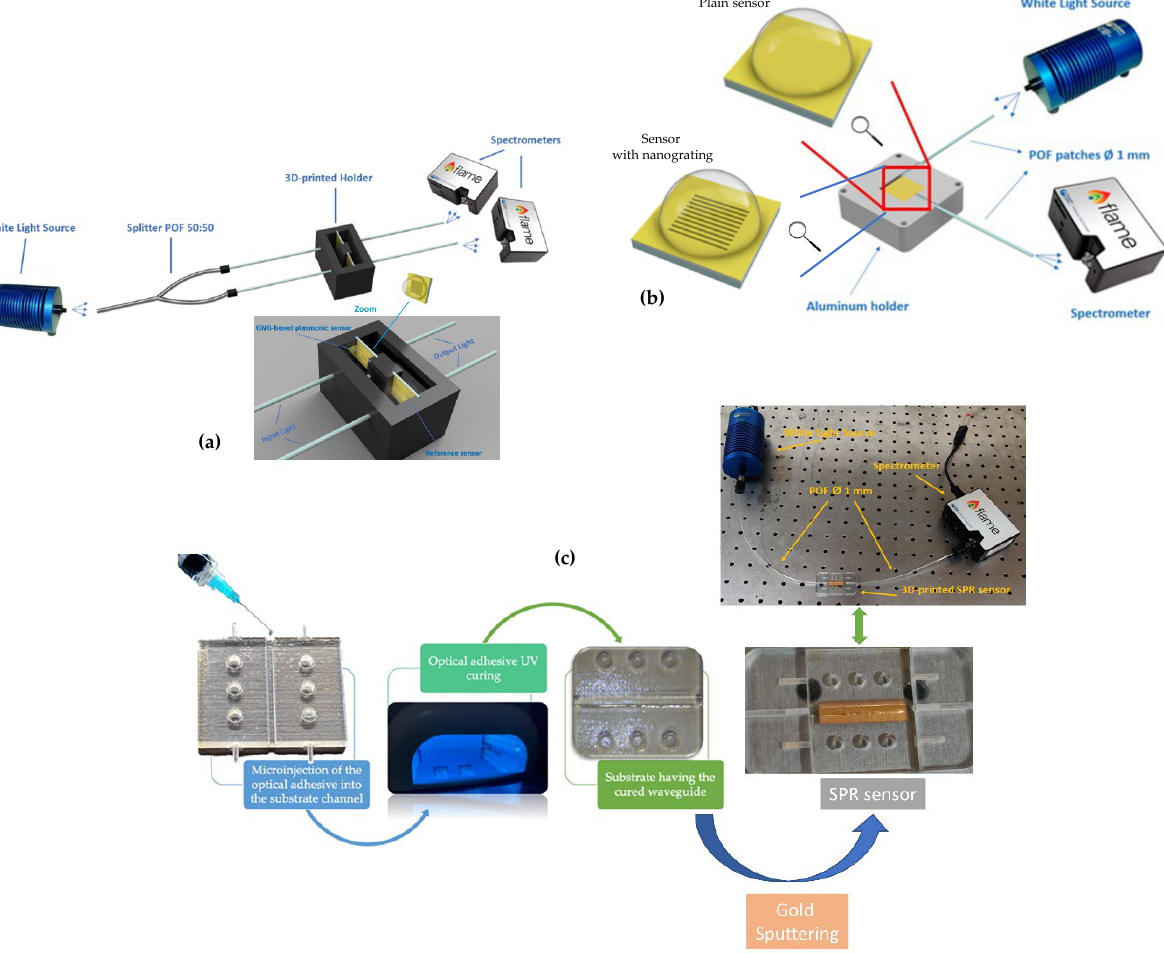
Figure 8. Plasmonic sensor configurations based on extrinsic POF sensors: ( a ) PMMA-based nanoplasmonic sensor chip monitored by exploiting the transparency of the substrate (image adapted from [63]); ( b ) PMMA-based plasmonic chips monitored by a custom setup produced to excite the plasmonic phenomena via the multimode slab waveguide (image adapted from [64]); ( c ) 3D printed SPR sensor chip with the respective setup (image adapted from [62]).